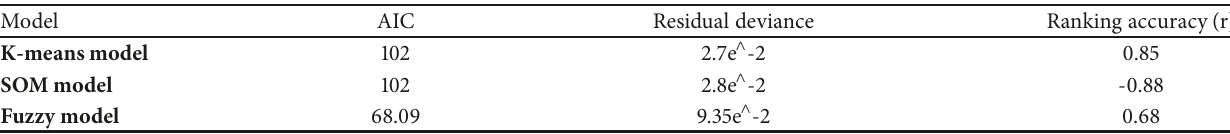
Table 7: Cluster model parameters and ranking accuracy (membership reallocation) based on spearman rank correlation for the Tanzania dataset. Model K-means model SOM model Table 8: Estimates of prediction accuracy for models fitting cluster of production for milk yield, milk sales, and choice of breeding method in Ethiopia. Algorithm/Response Variable Milk yield Milk sold K-means Fuzzy Table 9: Estimates of prediction accuracy for models fitting cluster of production for milk yield, milk sales, and choice of breeding method in Tanzania. Algorithm/ Response Variable Milk yield Milk sold Preferred breeding method K-means